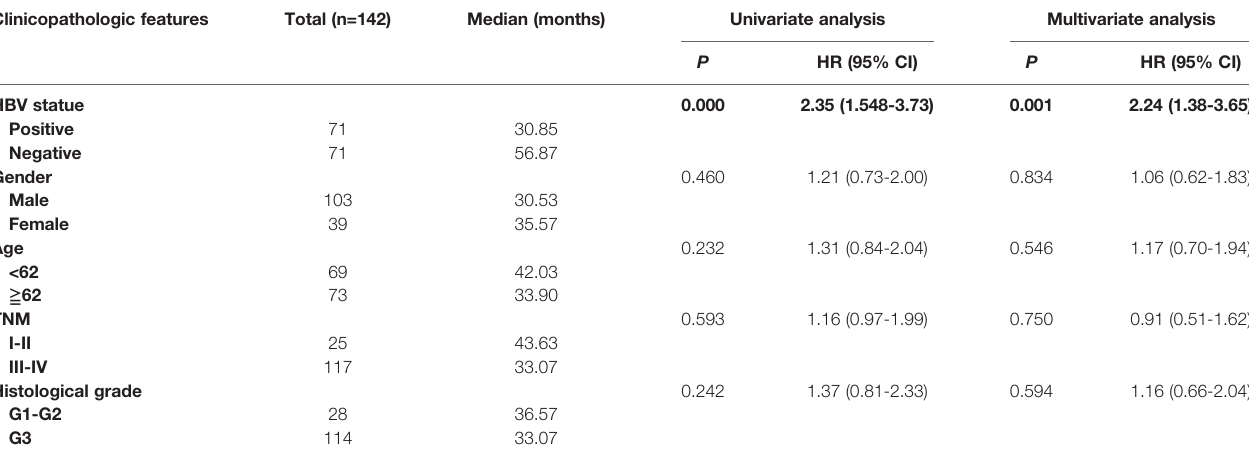
TABLE 4 | Univariate and multivariate Cox regression analyses for overall survival in patients with gastric cancers. Clinicopathologic features